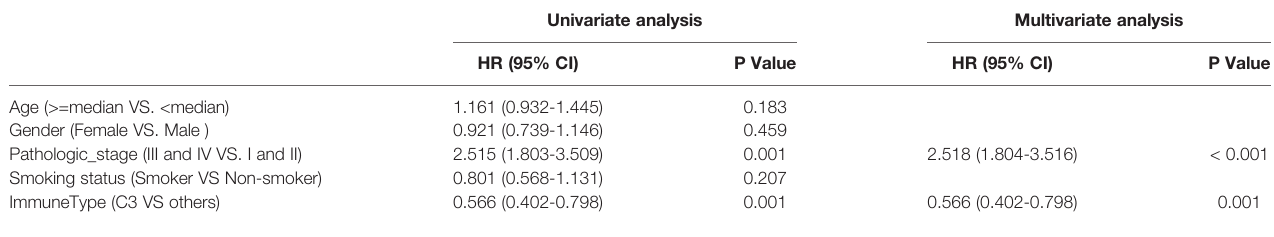
TABLE 1 | Univariate and multivariate Cox analyses of risk factors for survival prediction in TCGA LUAD cohorts. Univariate analysis Multivariate